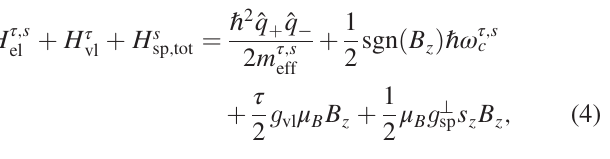
TABLE II. Valley ( ~ g different